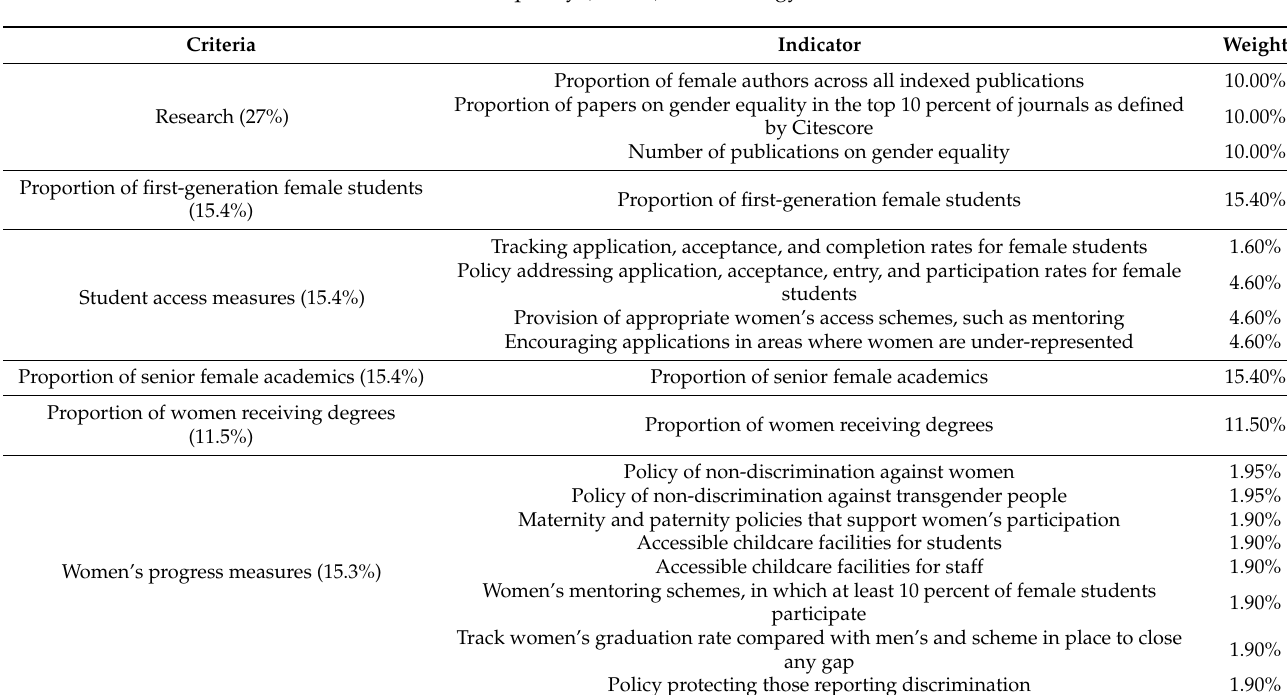
Table 2. Gender Equality (SDG 5)